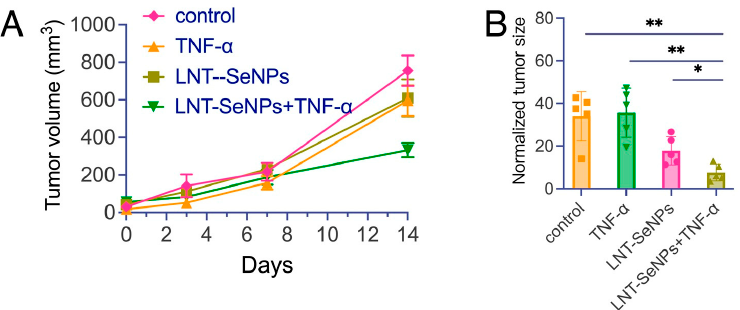
Figure 8. Inhibition of LNT-SeNPs on the growth of CT26 tumors. ( A ) Growth curves of the tumors in mice receiving different treatments. ( B ) Normalized tumor size at 14 days post treatment. All data are presented as the means ± SD (n = 5). Significant differences are indicated as p < 0.05 (*) and p < 0.01 (**).